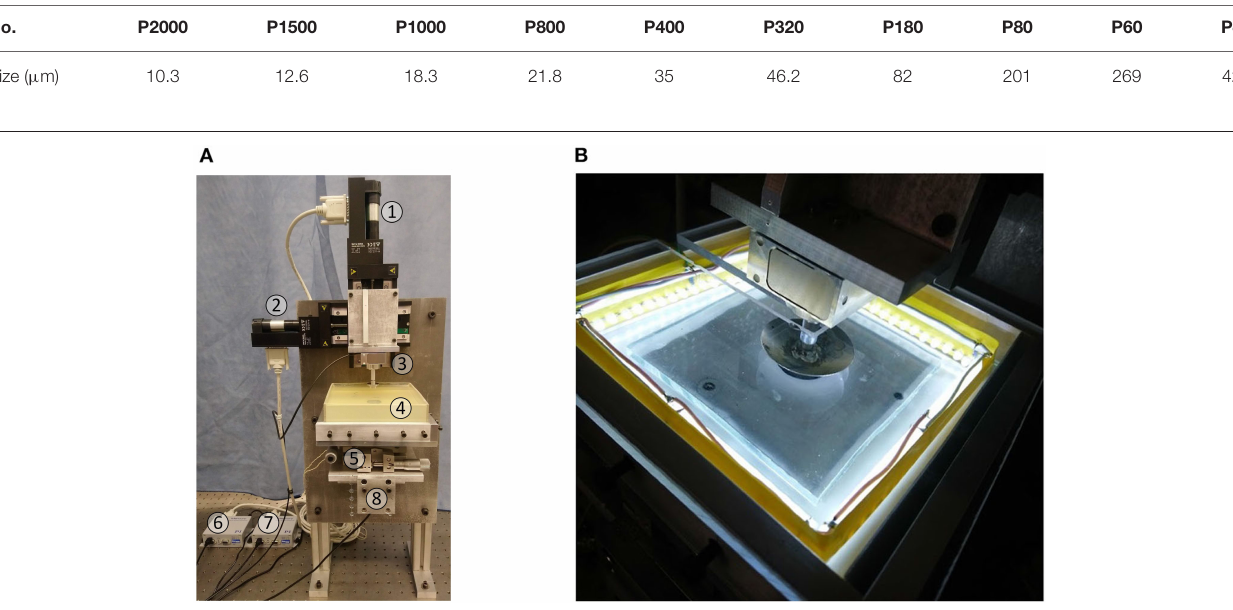
force correspond to the detachment process (pull-off). At